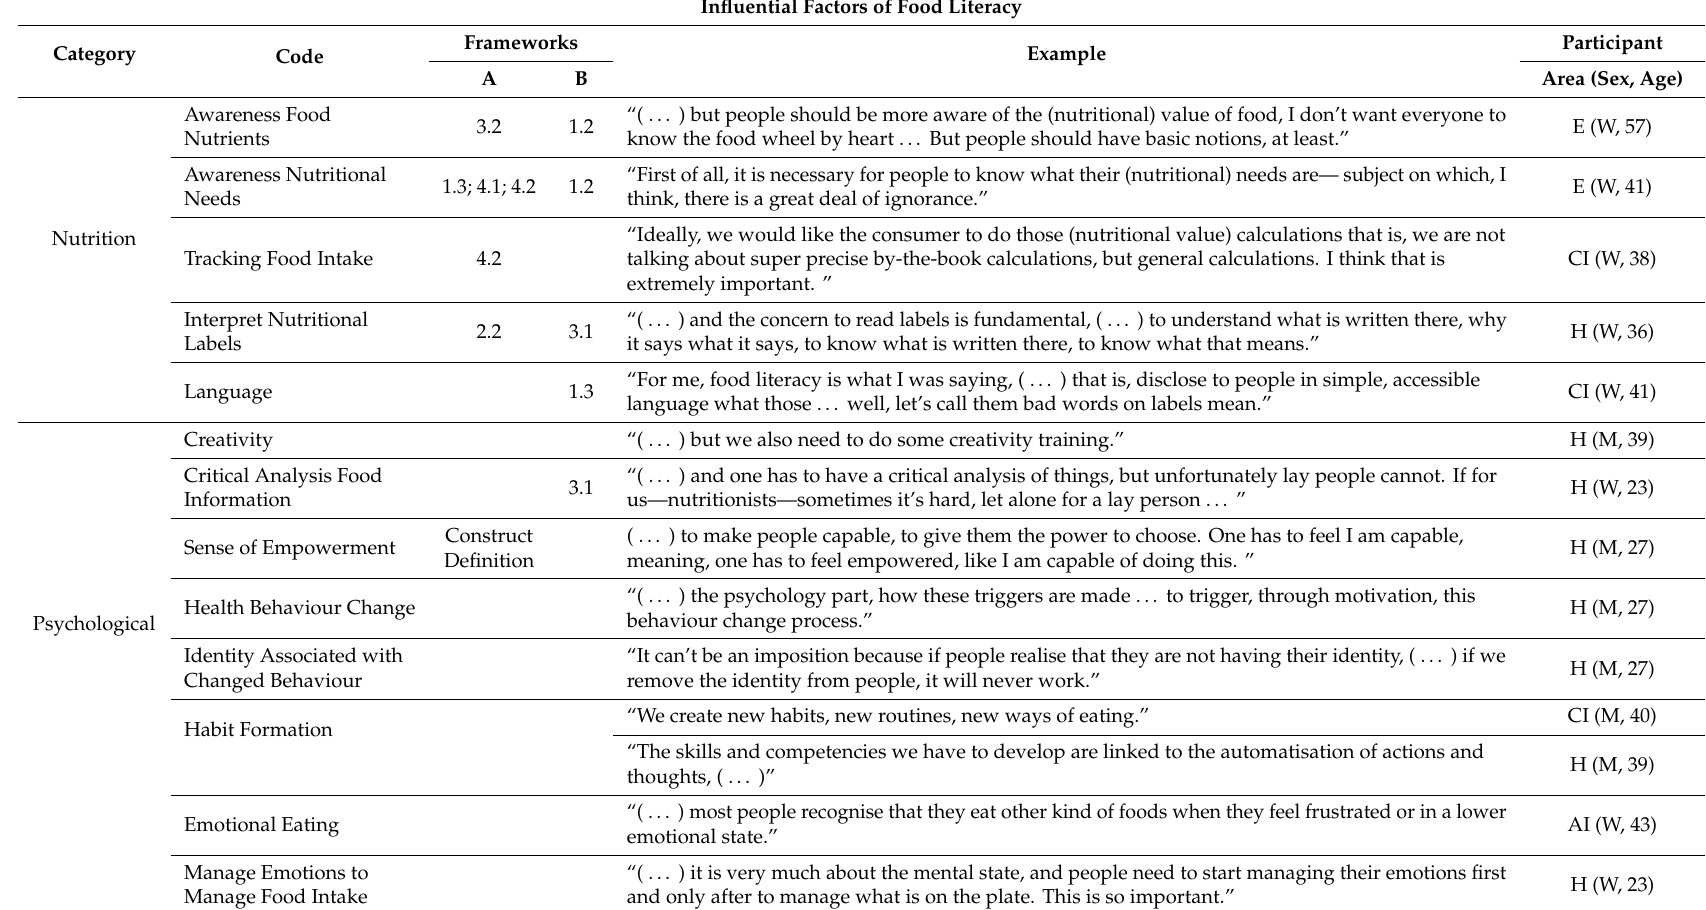
Table 3. Representation of the theme “Influential Factors of Food Literacy”, its categories and respective attributes (codes), the coding against conceptual frameworks [3,13], an exemplifying quote and its respective author’s professional and demographic